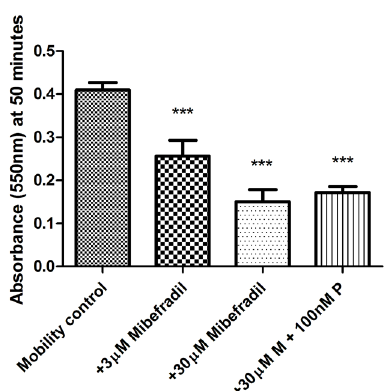
Figure 3. Progesterone (P) does not recover the mibefradil mediated inhibition of mobility of non-capacitated boar sperm cells. Maximum absorbance values at 50 minutes are given for sperm penetrating the Accudenz solution only (mobility control, 14 replicates) or containing mibefradil (M, +3/30 m M, 19 and 17 replicates respectively) or 30 m M mibefradil and 100nM Progesterone (+30 m M M + 100nM P, 26 replicates). Data are analysed using ANOVA followed by Tukeys post- hoc test. Asterisks ( *** P<0.001) indicate significantly different from mobility control. Data sets are an average of 4 ejaculates from different boars with pooled replicates as